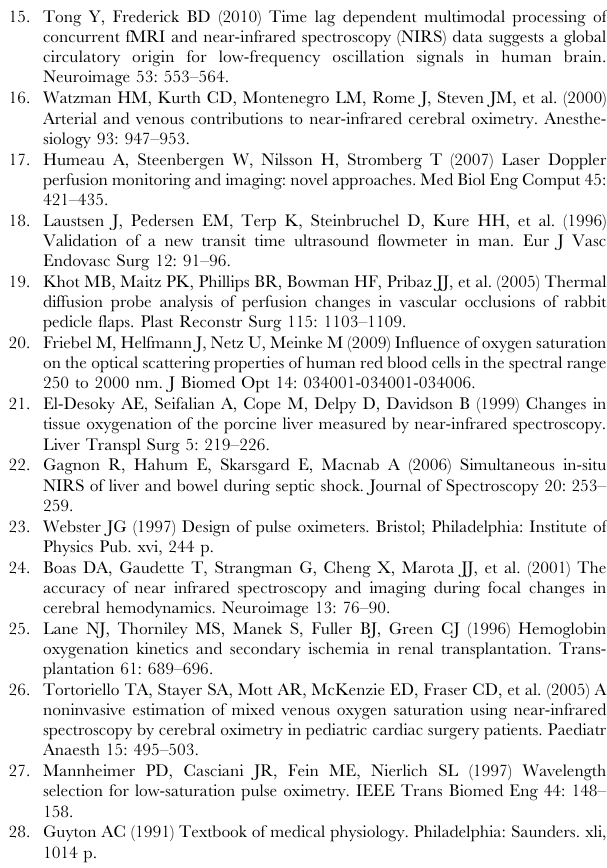
Figure S1 CAD drawings of the probes. a-Suture holders for the parenchymal, HA, and PV probes (left to right). b & c- CAD drawing of a parenchymal and a vascular probe respectively. Figure S2 The optical sensors used in the studies. (Left) CAD drawing of the electronics box showing the PCBs inside. (Right) Picture of the telemetry system showing the sensor, probes, and data acquisition software. Figure S3 Laser Doppler and transit time Doppler perfusion and flow measurements. Scatter plots of the Laser Doppler data versus HA flow (left), PV flow (middle), and total hepatic flow (right). The data shows that the LD data correlates best with the HA flow suggesting that the system was probing a branch of the HA. Figure S4 Reference flow measurements. Data from the transit time flowmeters (left axis) and Laser Doppler flowmeter (right axis). The time segments highlighted in red correspond to